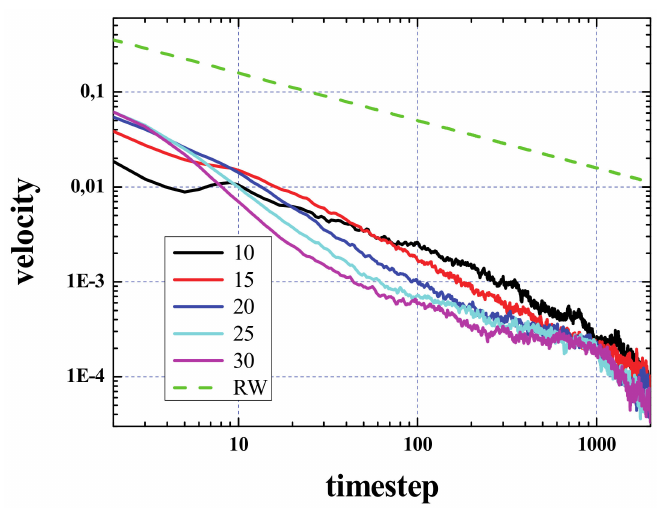
Figure 6. (Color online). Velocity vs. time for five different initial densities as labelled. The green dashed curve shows the result assuming a simple random walk. Note the logarithmic scale on both